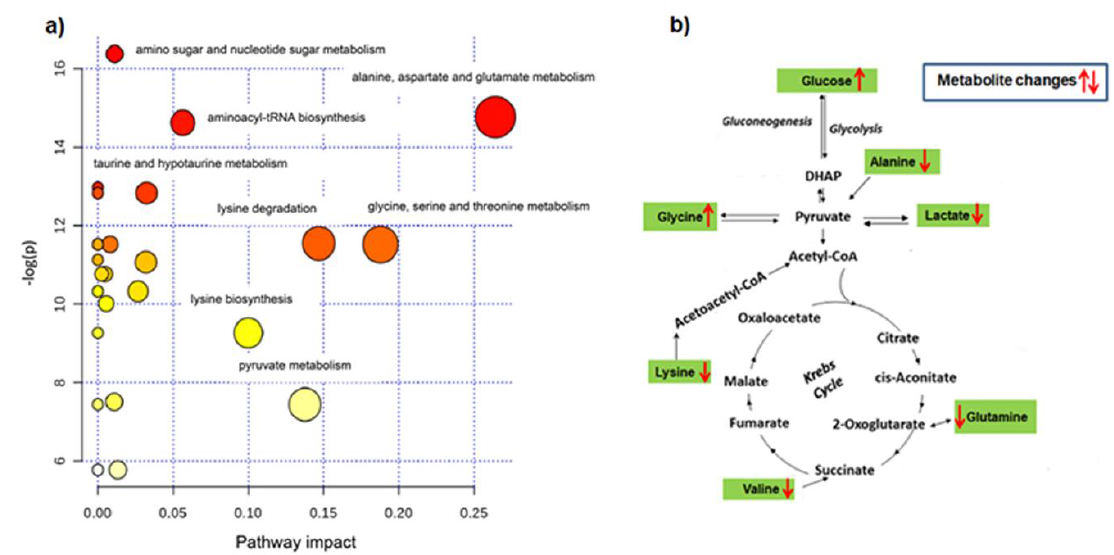
HCC patients. Nodes in red indicate significance ( p < 0.05), and the size of the nodes indicate impact. ( b ) Main pathways through which amino acids supply the Krebs cycle to furnish energy. Red arrows indicated the change direction: metabolite increased (upward arrow) and metabolite decreased (down arrow) in advanced with respect to early HCC patients.